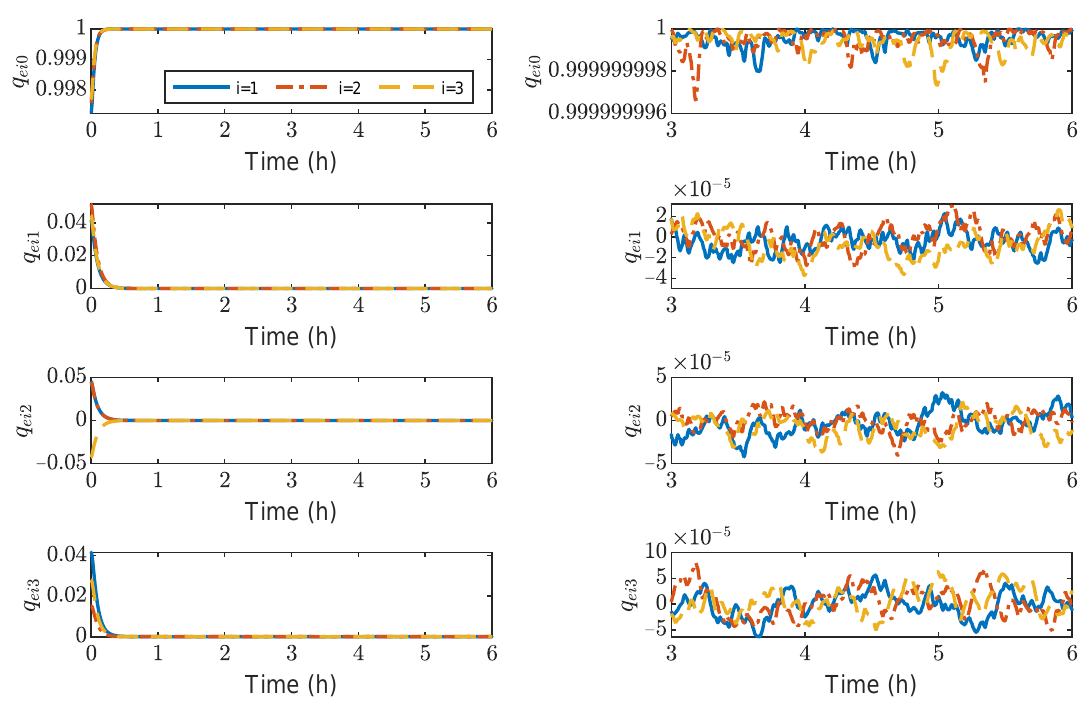
Figure 16. Relative attitude errors of spacecraft SC1 ∼ 3, the max control torque of spacecraft is 100 mN ·